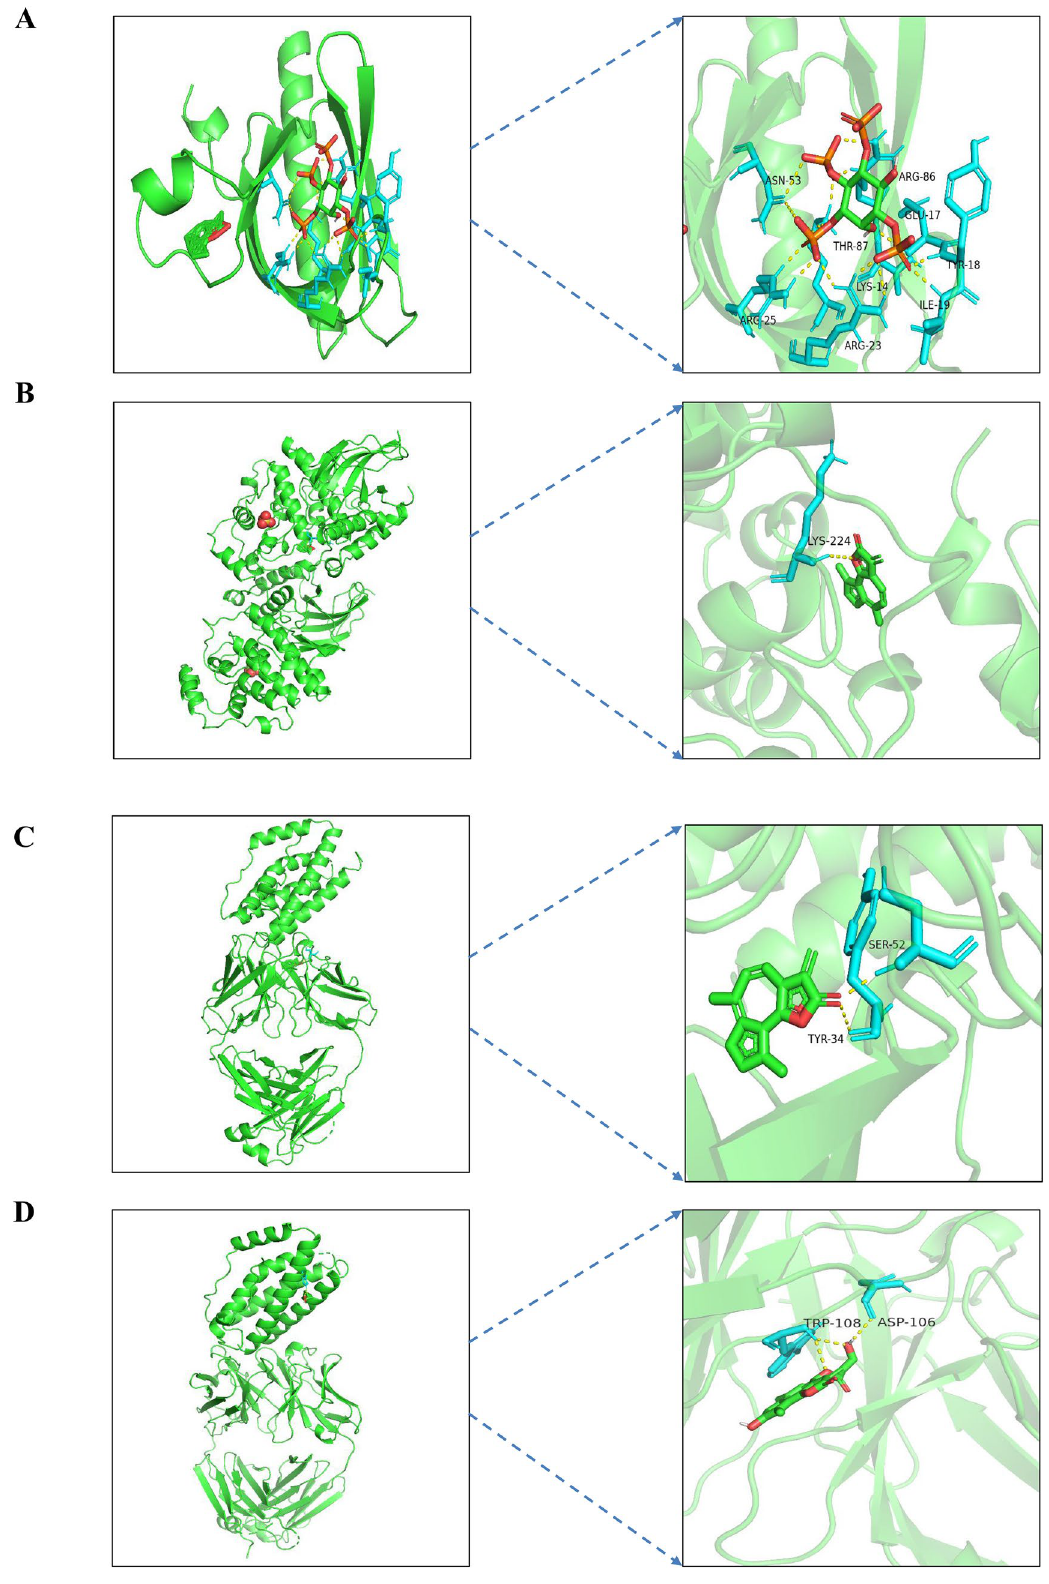
Figure 8. Schematic diagram of docking between eremanthin and proteins. Molecular models of eremanthin binding to the predicted target proteins ( A ) 1UNQ, ( B ) 6GES, ( C ) 4O9H, ( D ) 6OPH, ( E ) 7JXP, ( F ) 6E6E, ( G ) 7KPA, ( H ) 6WZM, ( I ) 6X8K, and ( J )